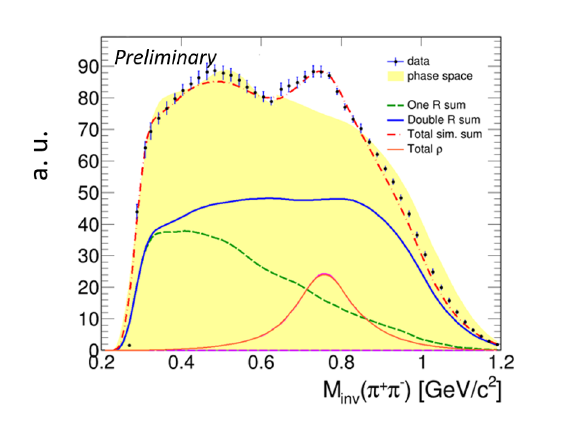
Figure 10. π + π − invariant mass distribution after applying the kinematical rejections M in v ( p π + ) < 1.3 GeV / c 2 , M in v ( p π − ) < 1.3 GeV / c 2 and θ lab ( p ) < 30 ◦ , compared to phase space (yel- low area). The blue (respectively dashed green) curves represent the double (respectively single) resonance contribution from the resonance model (see text) and the red curve is the direct ρ con- tribution. The dashed red curve shows the total